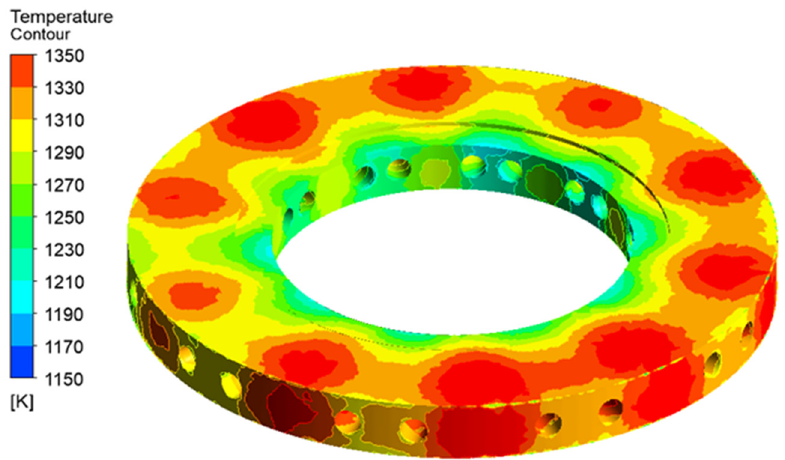
Figure 17. Temperature contours on the disk—coupled heat transfer case at 70 m/s.